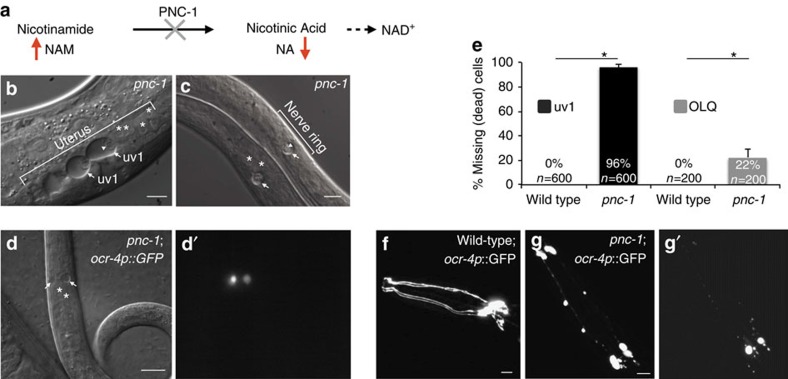
NAM-induced cell death affects two cell types in pnc-1 mutants.(a) PNC-1 converts NAM to NA during salvage biosynthesis of NAD+. Loss of PNC-1 results in accumulation of NAM. Both the b uterine uv1 cells and the c dying cells in the nerve ring in pnc-1(pk9605) null mutants (strain HV560) have a similar necrotic morphology. The cell bodies swell to many times normal size (arrows), while the nuclear membrane disintegrates and the nucleus moves to the cell periphery (arrowheads). (d) DIC image and d′ corresponding fluorescence image of a pnc-1 mutant carrying the psEx279[ocr-4p::GFP] transgene. The dying cells in the region of the nerve ring (arrows) are marked by GFP. For comparison to swollen cells, multiple cells of normal morphology and size are annotated in b–d with an asterisk directly above the nucleus and in Supplementary Fig. 1. (e) Quantification of the cell deaths in pnc-1 null mutants. uv1 cell death (black bars) was scored in late L4 according to the absence of cells with the inIs179[ida-1::GFP] marker (strain HV560), and OLQ (grey bars) death was scored in late L3 or L4 according to the absence of cells with the psEx279[ocr-4p::GFP] marker (strain HV695). Actual per cent missing cells and sample size (number of cells examined) is indicated on each bar. Error bars are 99% confidence intervals (not applicable to 0%). *P<0.0001, calculated using Fisher's exact test. (f) The dendrites of the OLQ cell extend to the tip of the nose, visualized in a wild-type animal carrying the ocr-4p::GFP transgene. (g,g′) Fluorescence images of the (g) late L3 and (g′) L4 stage of the same pnc-1; psEx279[ocr-4p::GFP] animal, demonstrating that death is a degenerative process involving (g) first the blebbing of the dendrites (g′) followed by their disappearance as the cell bodies round up and begin to disappear. Note that the image in g′ is overexposed relative to g. Scale bars in all panels are 10 μm.